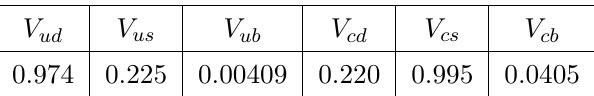
Table 7 . CKM matrix elements [65] adopted in this